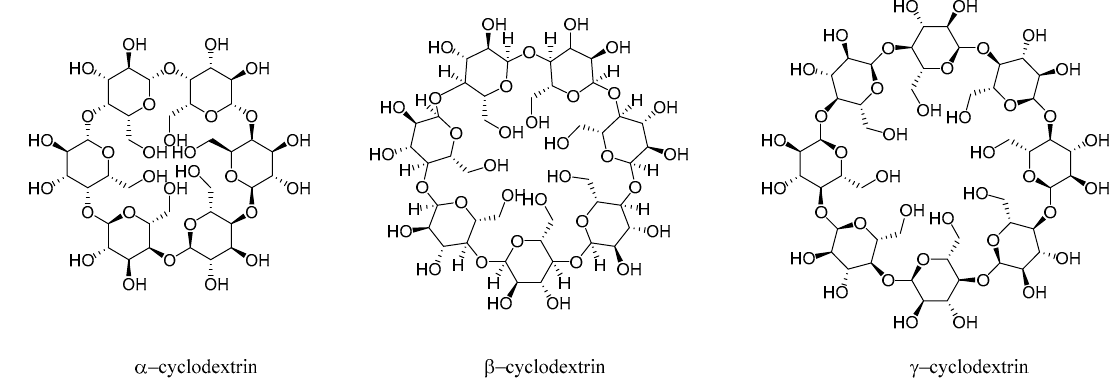
Figure 2. Chemical structures of α -, β - and γ -CD.